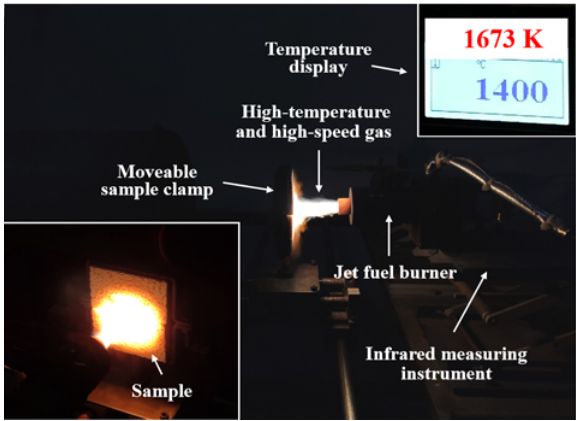
Photograph of a circular specimen under the burner rig test in burner bench